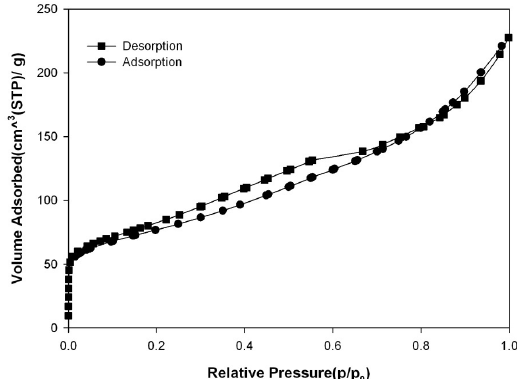
Fig.2. N 2 adsorption/desorption isotherms of MWCNT. Fig. 2. N adsorption/desorption isotherms of MWCNT. 2